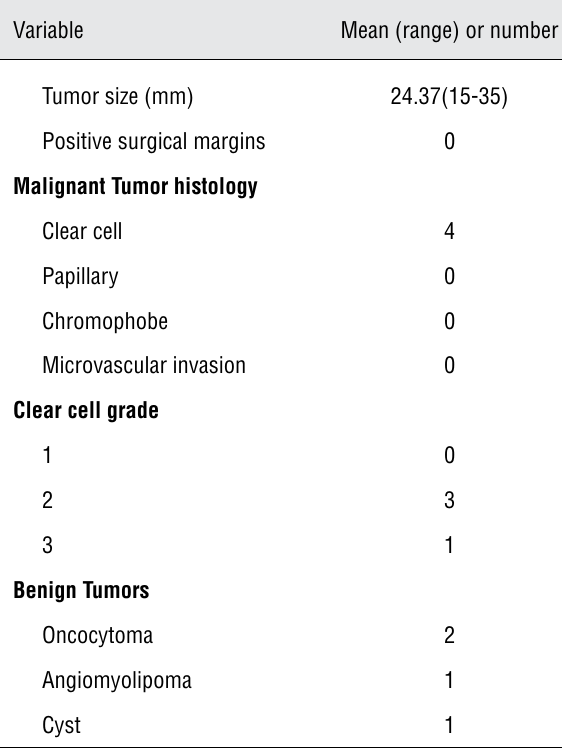
Table 3 - Pathologic data. Variable Mean (range) or number Tumor size (mm) 24.37(15-35) Positive surgical margins